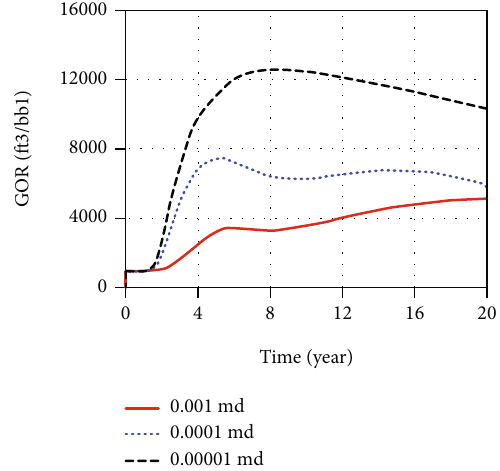
Figure 7: Simulated cases showing dependence of GOR on matrix permeability (horizontal). Higher matrix permeability gives stronger support and help to mitigate the GOR rise.